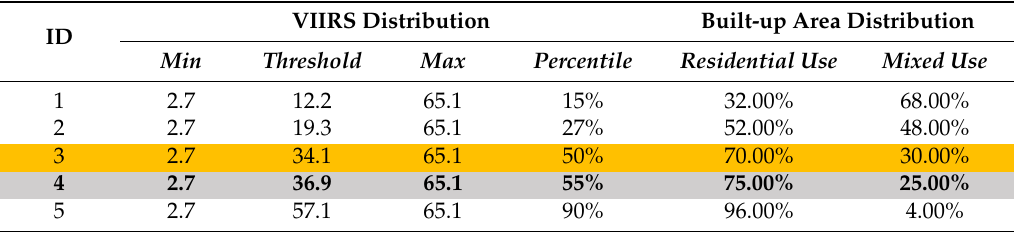
Table 3. VIIRS distribution thresholds (aggregated 30 arc-sec grid) and corresponding building use distribution ratios (grey indicating selected best-matching threshold, orange indicating 50% threshold for comparison).